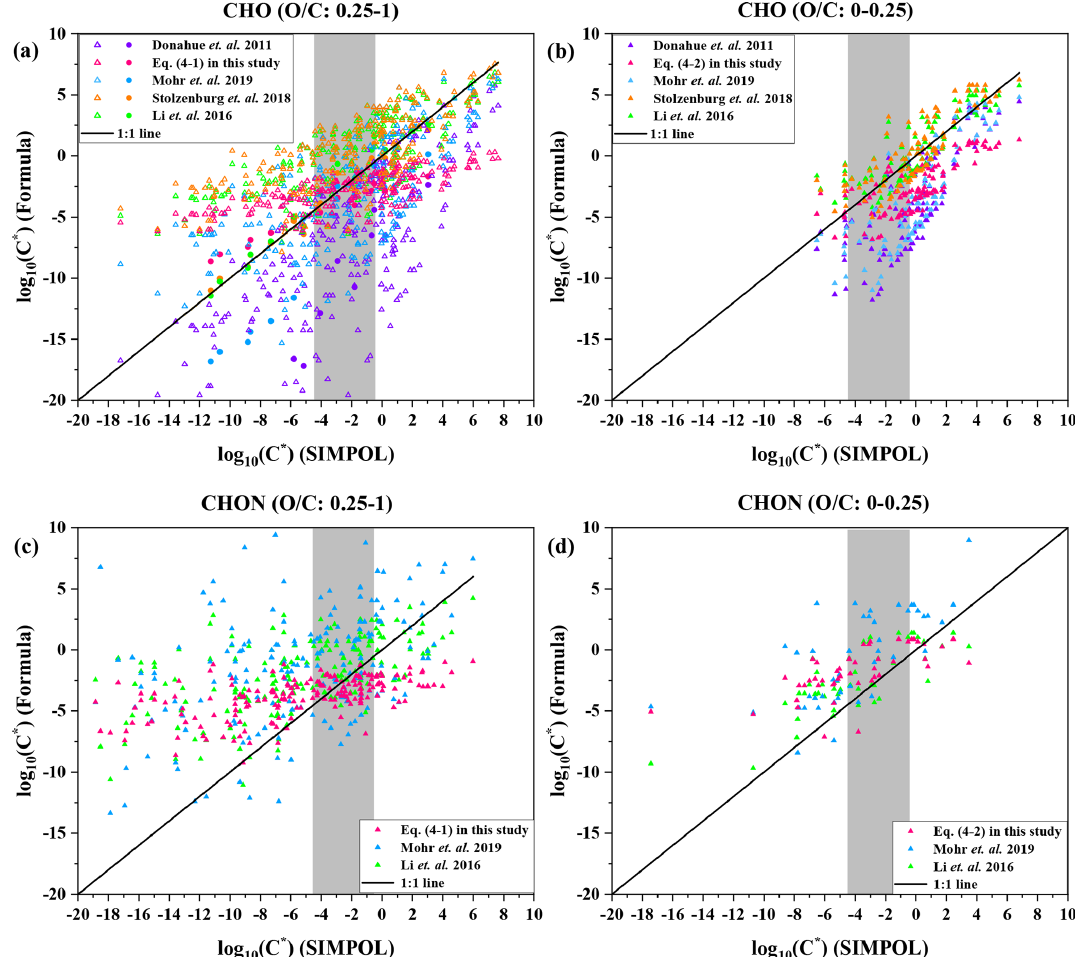
Figure 5. Saturation mass concentration ( C ∗ ) of 15 HOMs (O / C: 0.25–1) and 230 CHO compounds (O / C: 0.25–1) estimated by Eq. (4- 1) (a) , 106 CHO compounds (O / C: 0-0.25) estimated by Eq. (4-2) (b) , 183 CHON compounds (O / C: 0.25–1) estimated by Eq. (4-1) (c) , 46 CHON compounds (O / C: 0–0.25) estimated by Eq. (4-2) (d) , and the parametrizations from Donahue et al. (2011), Mohr et al.